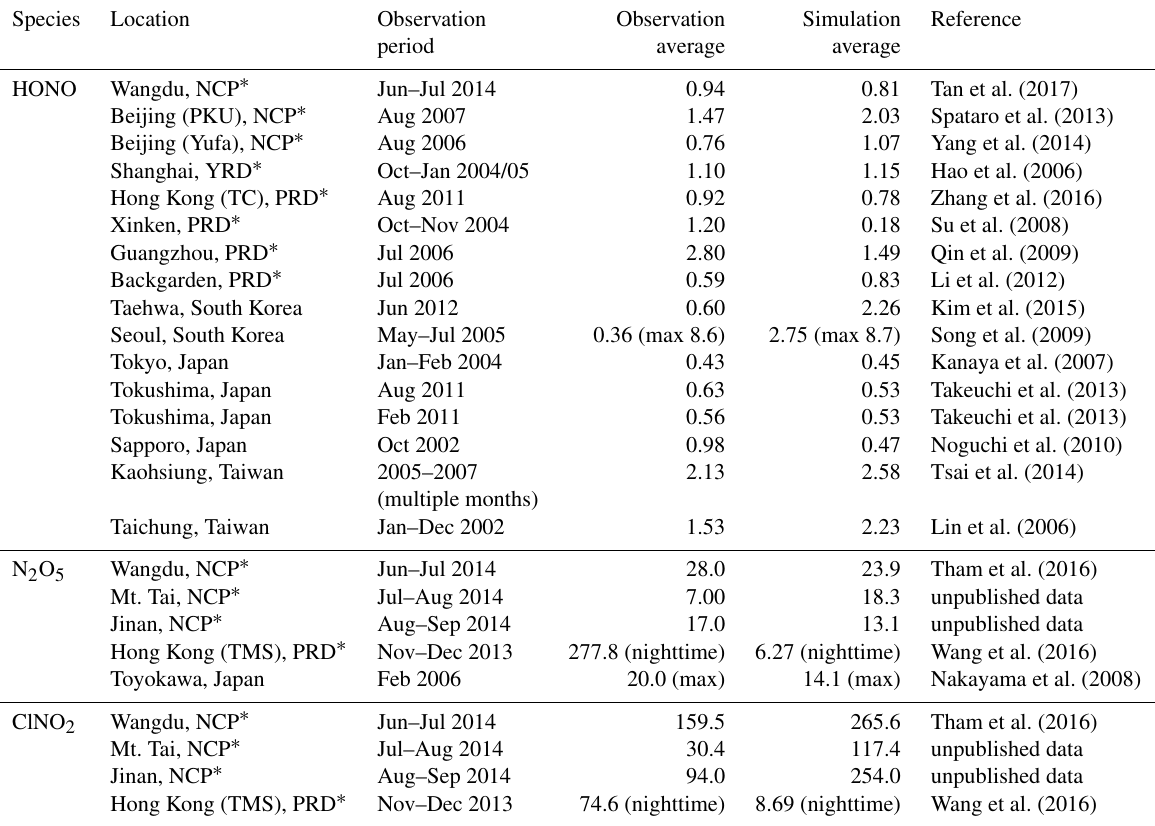
Table 4. Comparisons between simulated and observed HONO (ppb), N 2 O 5 (ppt), and ClNO 2 (ppt) over Asia from previous studies.